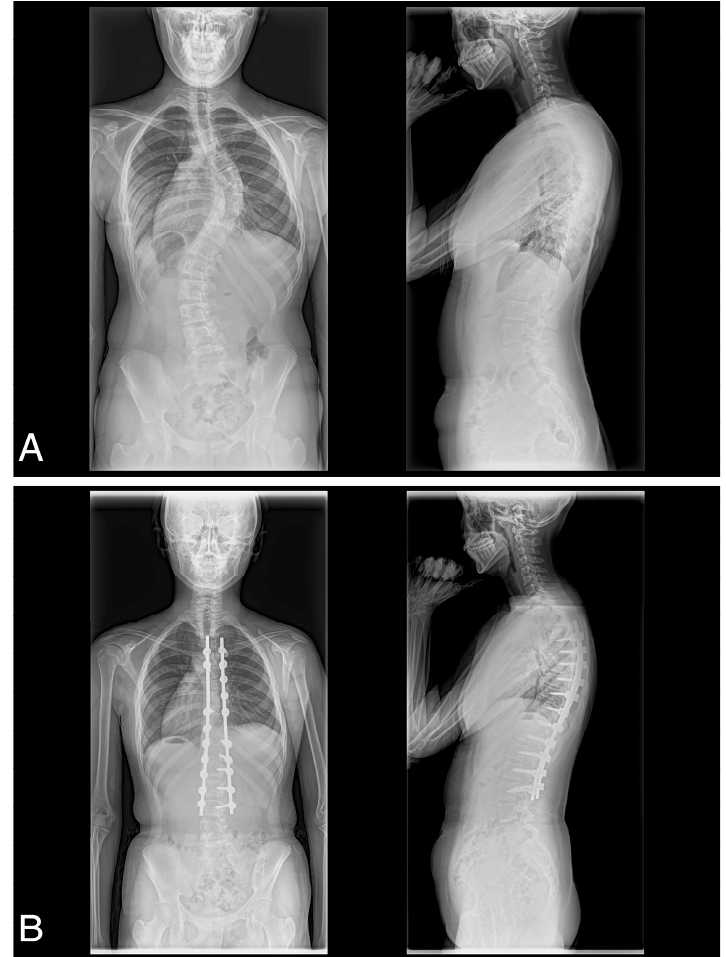
Figure 1. ( A ) Preoperative posteroanterior and lateral and ( B ) postoperative posteroanterior and lateral radiographs obtained of a 17-year-old female with Lenke type 1C scoliosis.